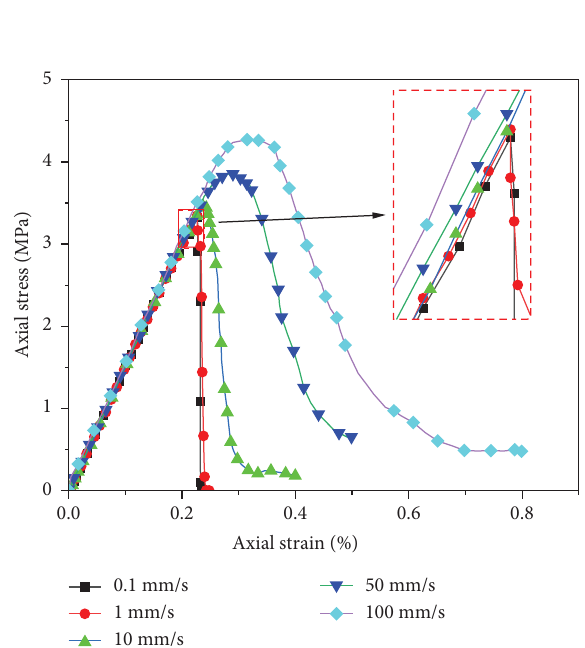
Figure 3: Uniaxial compression stress-strain curve of the backfll model.